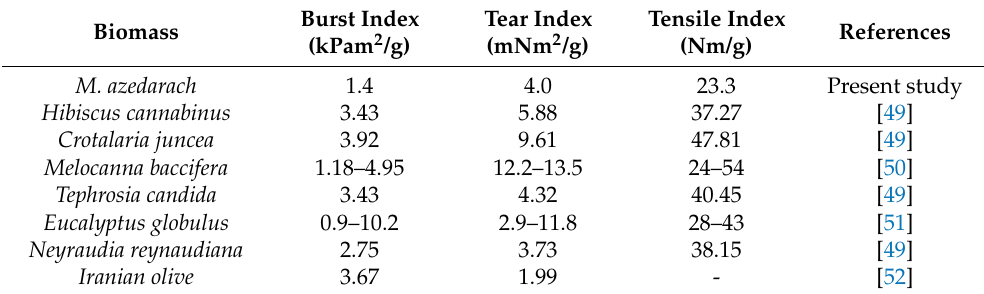
Table 5. Physical properties of the pulp sheet in the present study and other raw biomass materials.